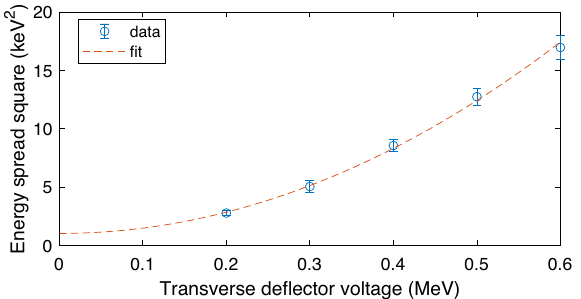
FIG. 4. Square of the reconstructed energy spread as a function of the deflector voltage for a case in which the initial energy spread is 1 keV.